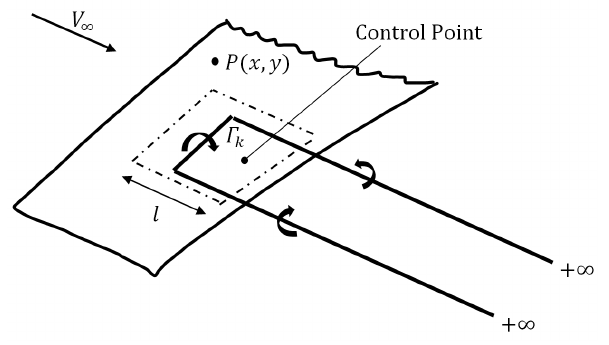
Figure 3. VLM horseshoe